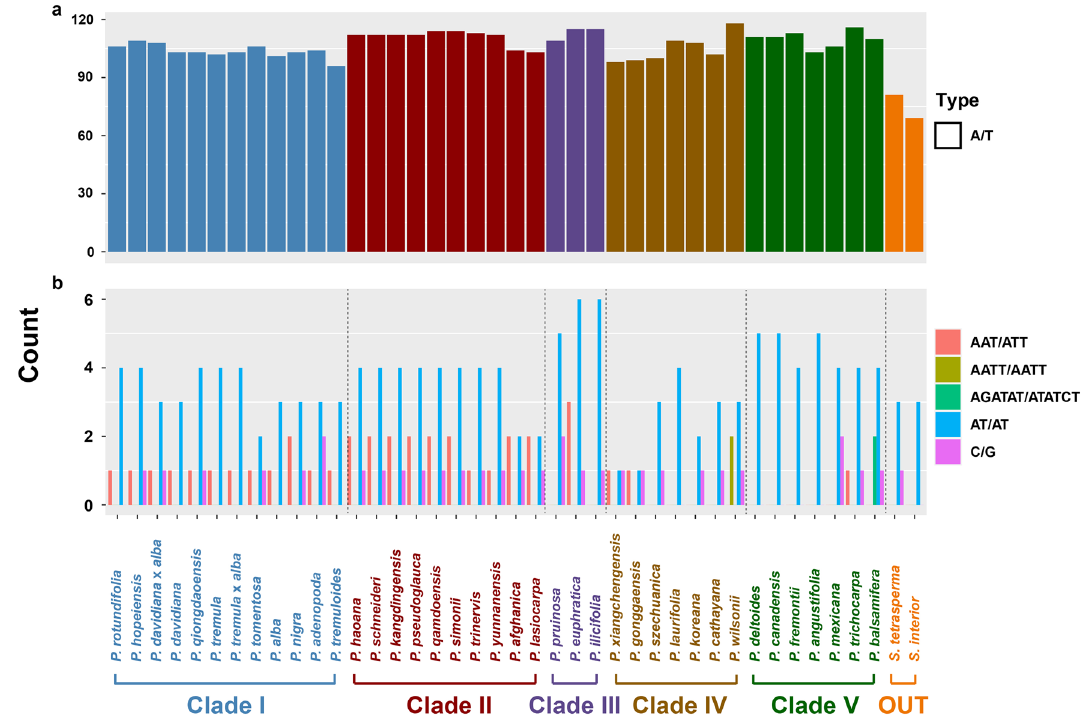
Figure 4. The number of Simple Sequence Repeats (SSRs) in Populus chloroplast genomes and two out-group species. a: A/T SSRs; b: other common SSR